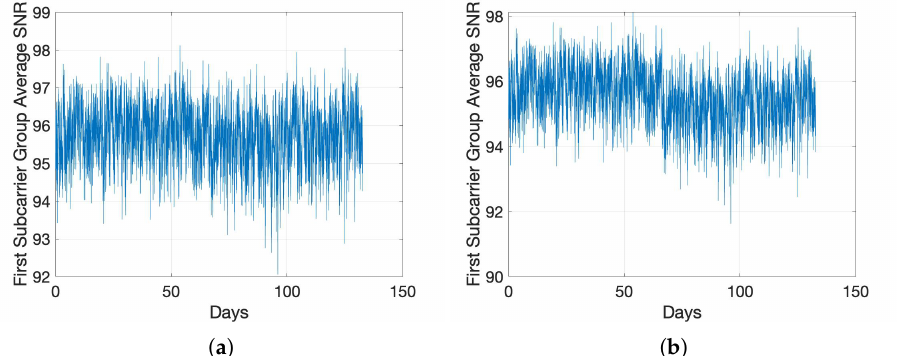
Figure 5. Average SNR with mild and medium DFs for the stabilizer batch i = 1 with LI model 1.